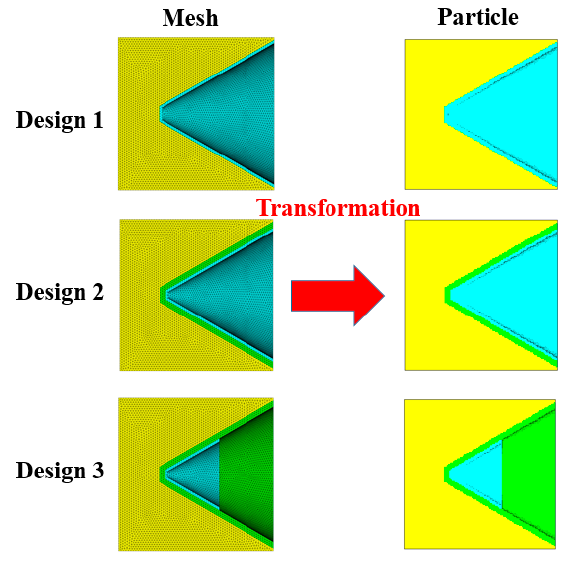
Figure 12. Transformation diagram.